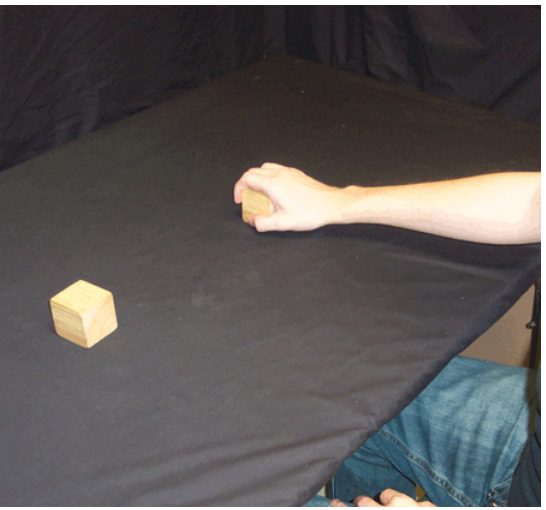
Fig 5. Reach and Retrieve condition. Participant reaches out and grabs the action block.